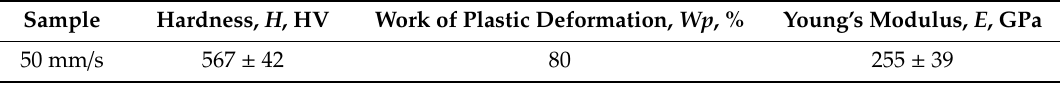
Table 1. Mechanical properties of the sample processed at 50 mm / s scan